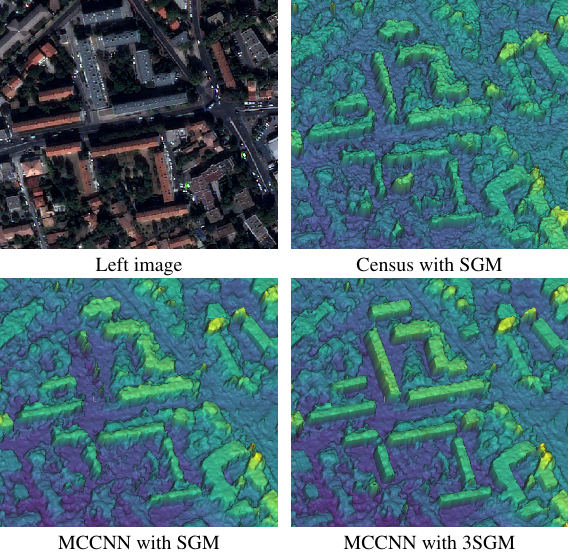
Figure 3. Meshed DSMs on Montpellier (France). DSM building edges and corners are better reconstructed with 3SGM.